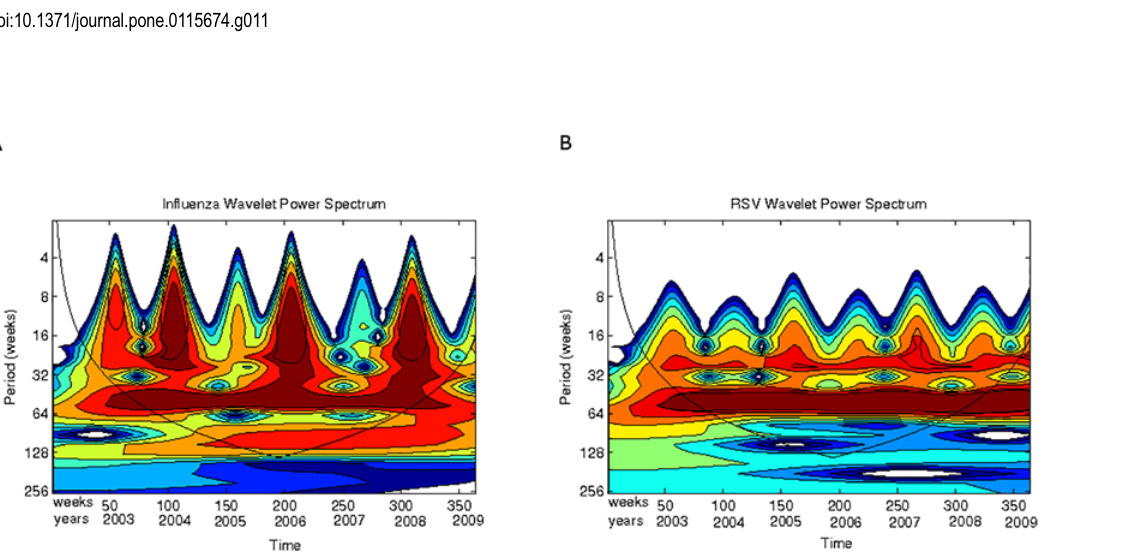
Fig 12. Scalogram (absolute values) for the model simulations for periods up to 128 weeks (32 months). (A) Influenza cases. (B) RSV cases. Horizontal axis, weeks numbered consecutively; vertical axis, periods in weeks. See text for explanation.